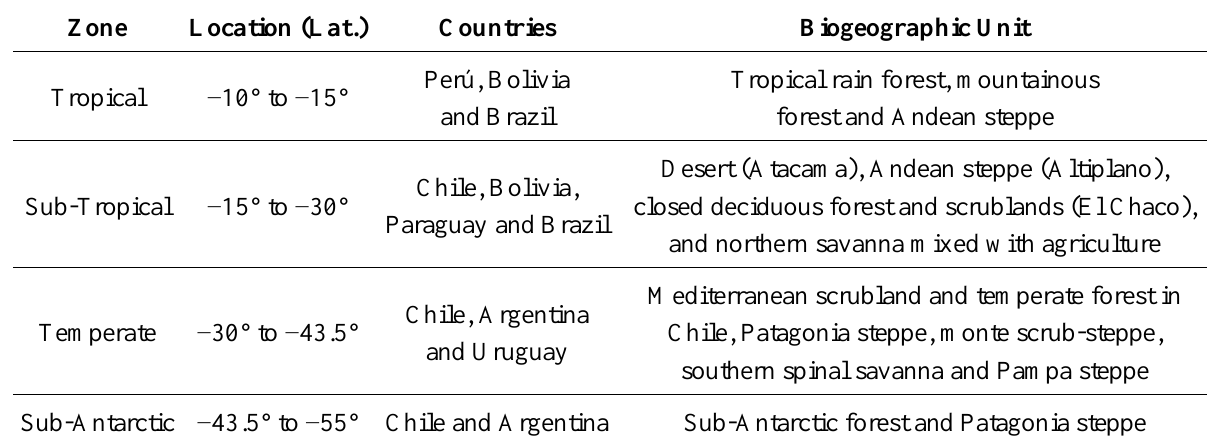
Table 1. Bioclimatic zones for the study area